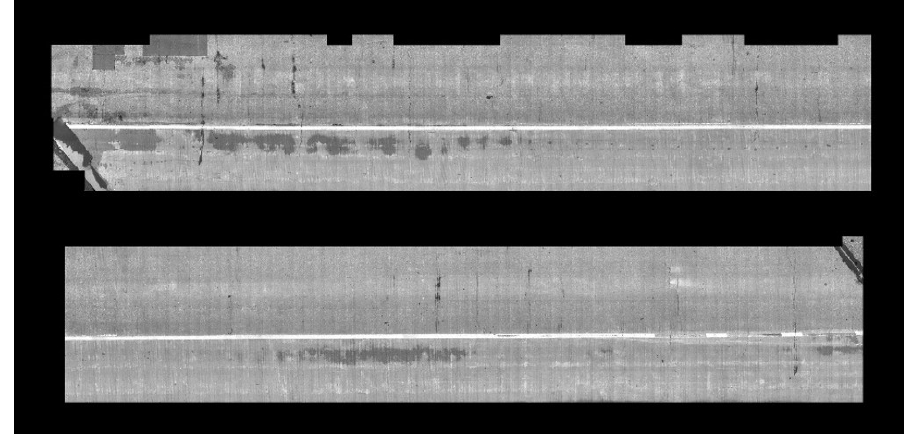
Figure 12. The reconstructed camera pose of all camera sequences and reconstructed 3D points (left image: zoom-out, right image: zoom-in).